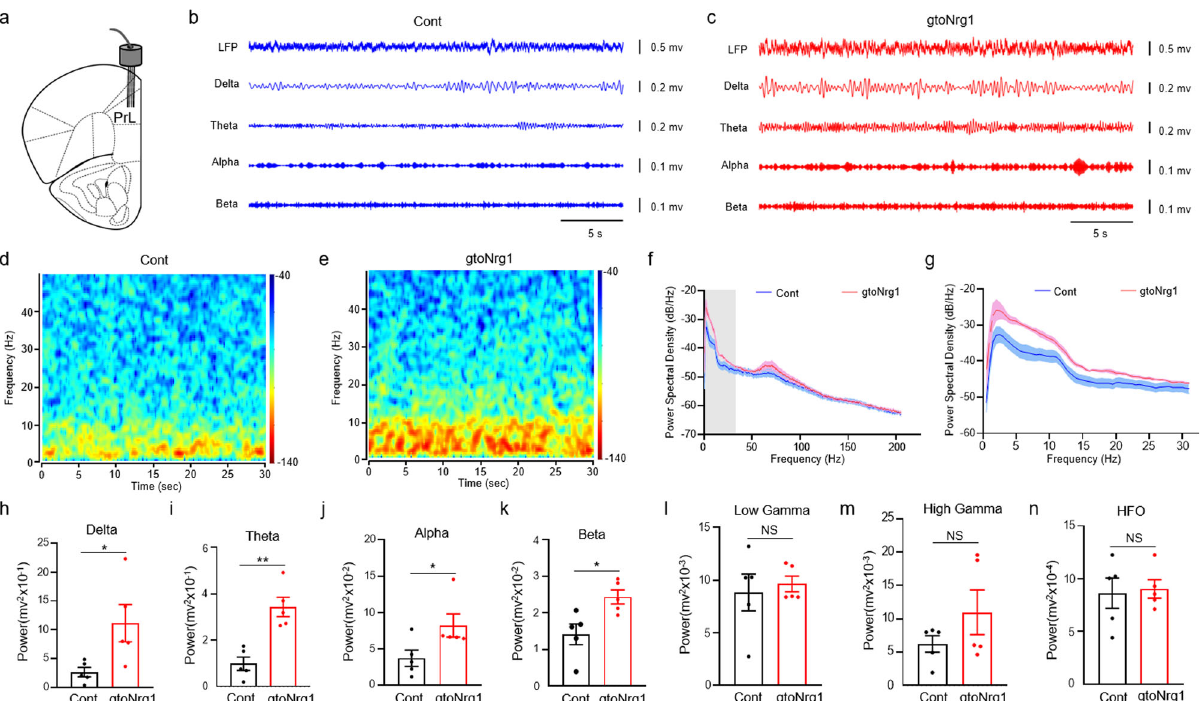
Fig. 3 Increased delta, theta, alpha, and beta oscillation in the PFC of freely behavioral gto Nrg1 mice. a Diagram to show the LFP recording in layers 2 – 3 of PrL. b , c Spontaneous LFP and fi ltered delta, theta, alpha, and beta component of the signal from control ( b ) and gto Nrg1 mice ( c ). d , e Power spectrogram of LFP from control ( d ) and gto Nrg1 mice ( e ). f Power spectral density of LFP from 0.5 to 200 Hz in control and gto Nrg1 mice. n = 5 for each group. Data are presented as mean values + / − SEM. g Power spectral density of LFP from 0.5 to 30 Hz in control and gto Nrg1 mice. n = 5 for each group. Data are presented as mean values + / − SEM. h – n LFP band-power in the delta (0.5 – 3 Hz) ( h ), theta (4 – 12 Hz) ( i ), alpha (13 – 15 Hz) ( j ), beta (16 – 30 Hz) ( k ), low gamma (30 – 50 Hz) ( l ), high gamma (55 – 90 Hz) ( m ), and high-frequency oscillation (HFO, 100 – 300 Hz) ( n ). NS, not signi fi cant, * P = 0.0345 for panel h , ** P = 0.0013 for panel i , * P = 0.0498 for panel j , * P = 0.0174 for panel k, two-sided t test, n = 5 for each group. Data are presented as mean values + / − fi ring rate varied between fast-spiking (FS) and non-FS- GABAergic interneurons. Here, we focus on FS-GABAergic interneurons whose function is critical for neuronal synchroniza- tion and is heavily diminished in the PFC from schizophrenia patients 32 . Intriguingly, the FS-GABAergic interneurons showed a downward shift of input – output (I/O) curves of action potential (AP) in gto Nrg1 ; Gfp mice, compared with gtoGfp mice (Fig. 4n, o), suggesting reduced excitability of FS-GABAergic interneurons in gto Nrg1 ; Gfp mice.